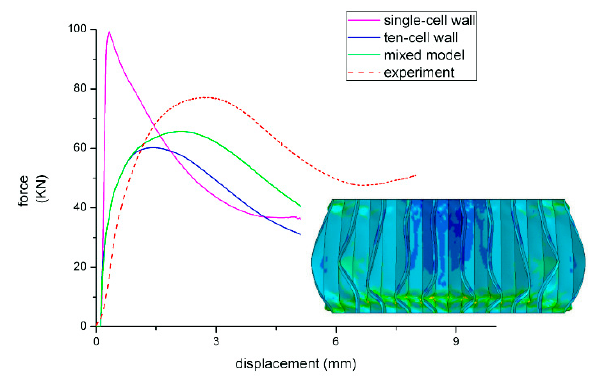
Figure 7. Simulation results with different models under out-of-plane compression.